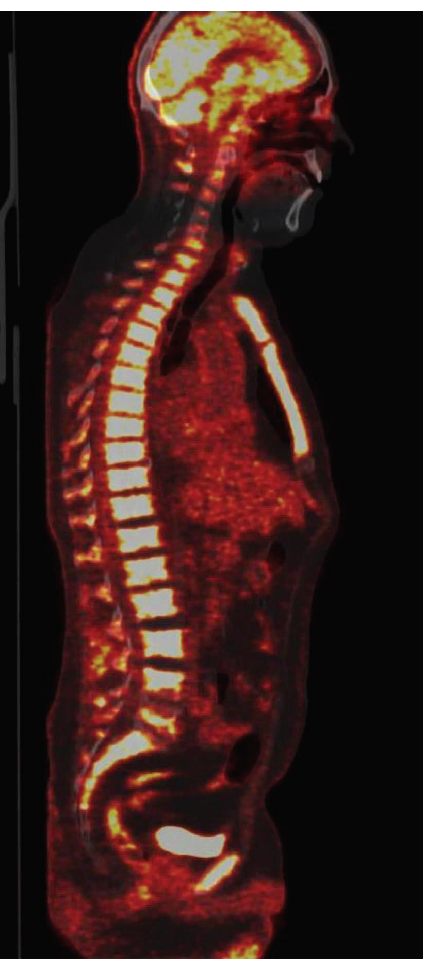
Figure 3: [F 18 ]FDG-PET-CT showing intense uptake in the central bone marrow. Table 1: Organ manifestations of VEXAS syndrome in the present